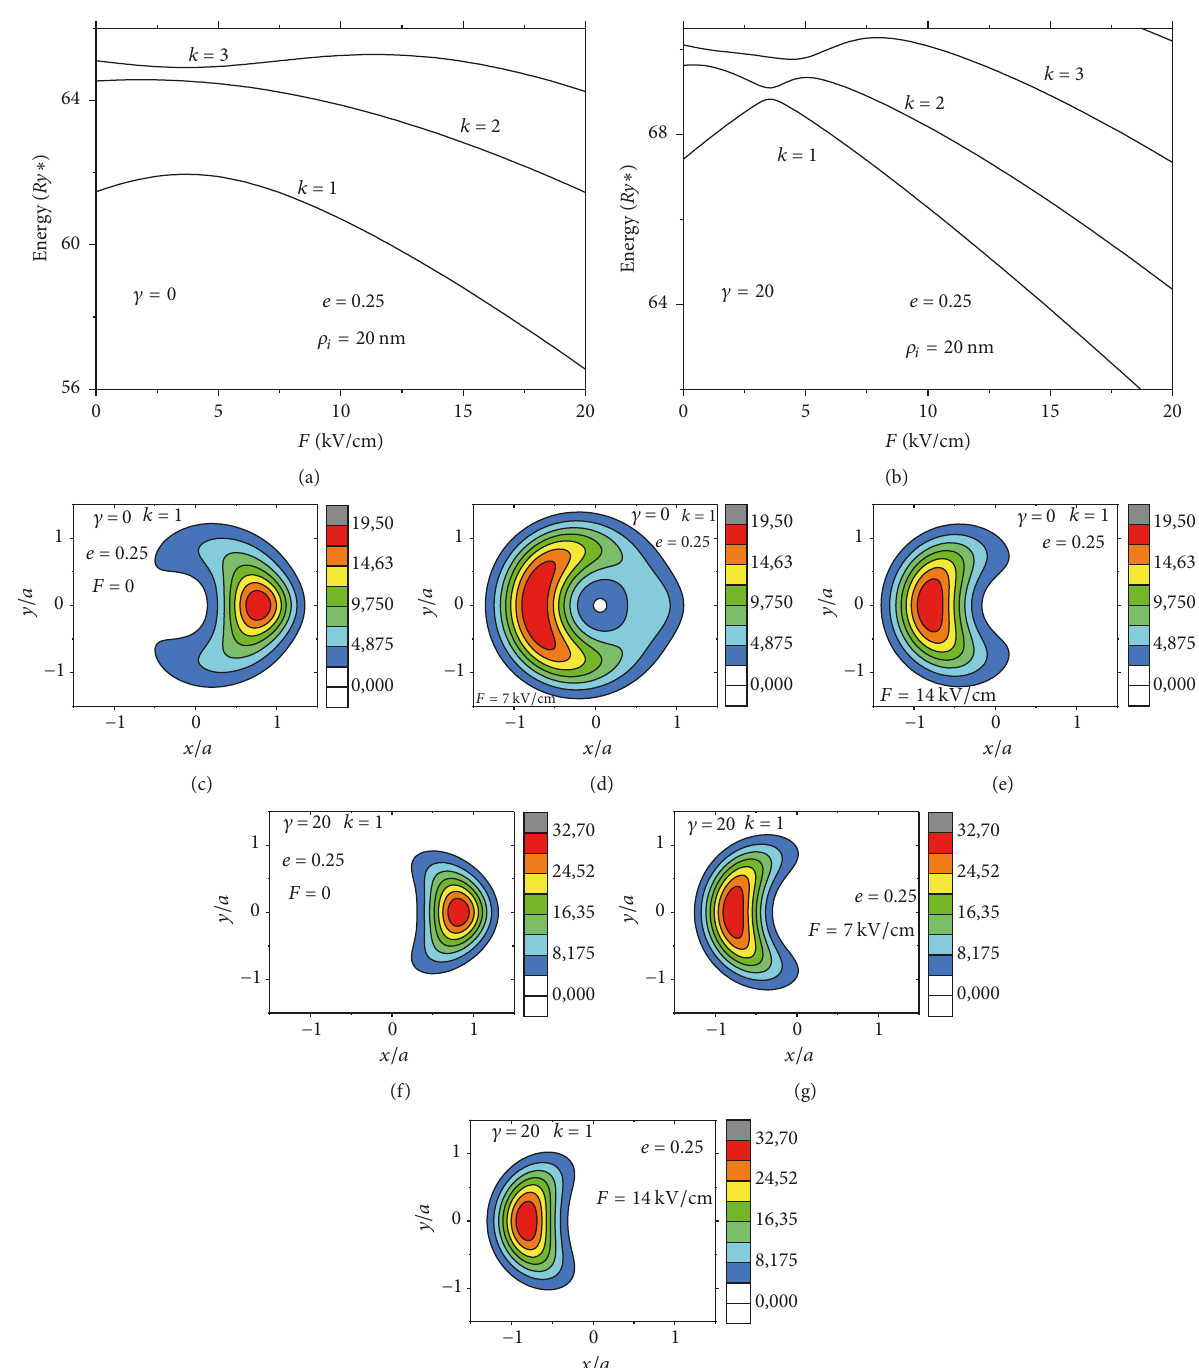
Figure 12: Lower energies of donor located at the crater’s rim of the elongated QR as functions of the electric field in the cases (a) zero- magnetic field and (b) 𝛾 = 20 and (c–f) contour plots for charge distributions.